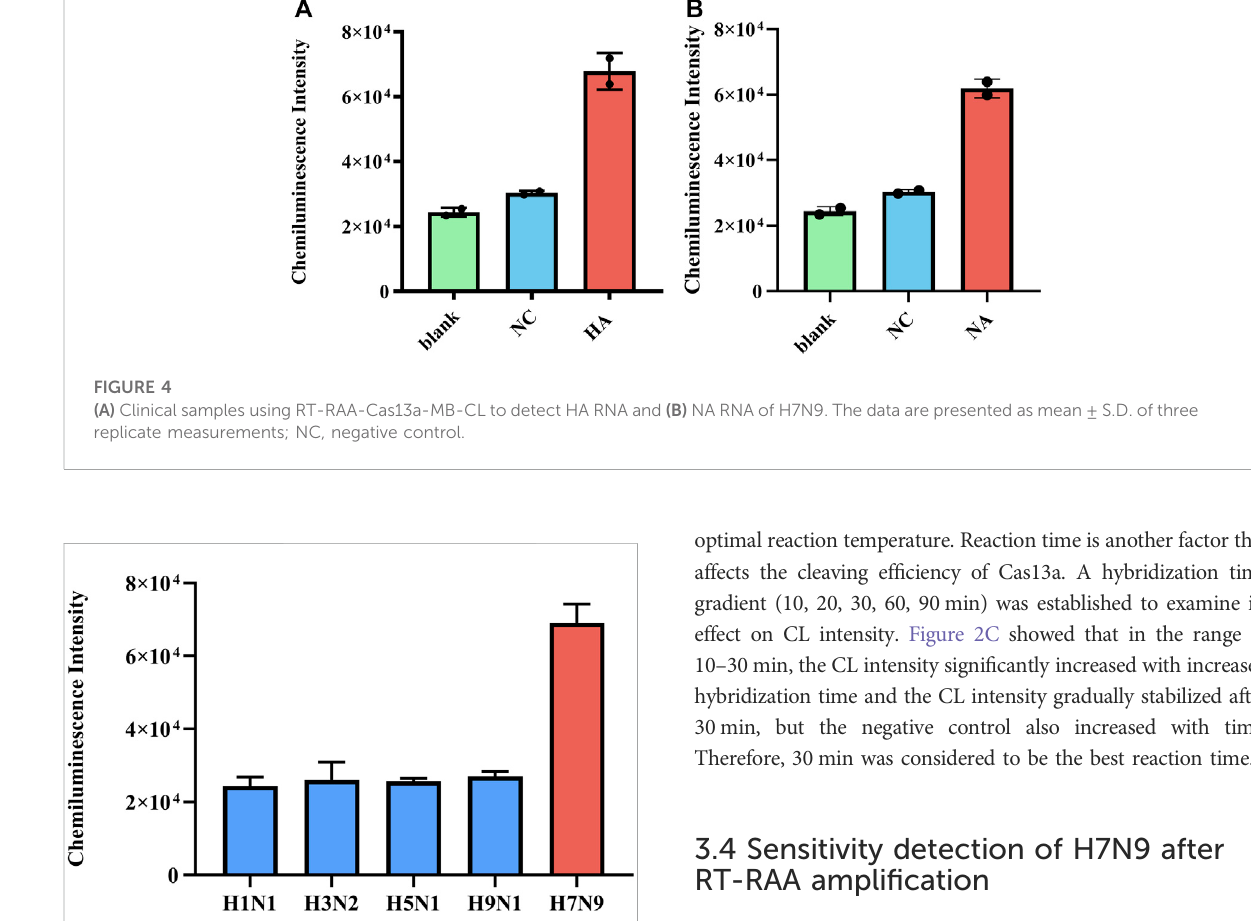
FIGURE 5 Speci fi city of RT-RAA-Cas13a-MB-CL detection of H7N9 virus samples against other in fl uenza virus samples for HA. The data are presented as mean ± S.D. of three replicate